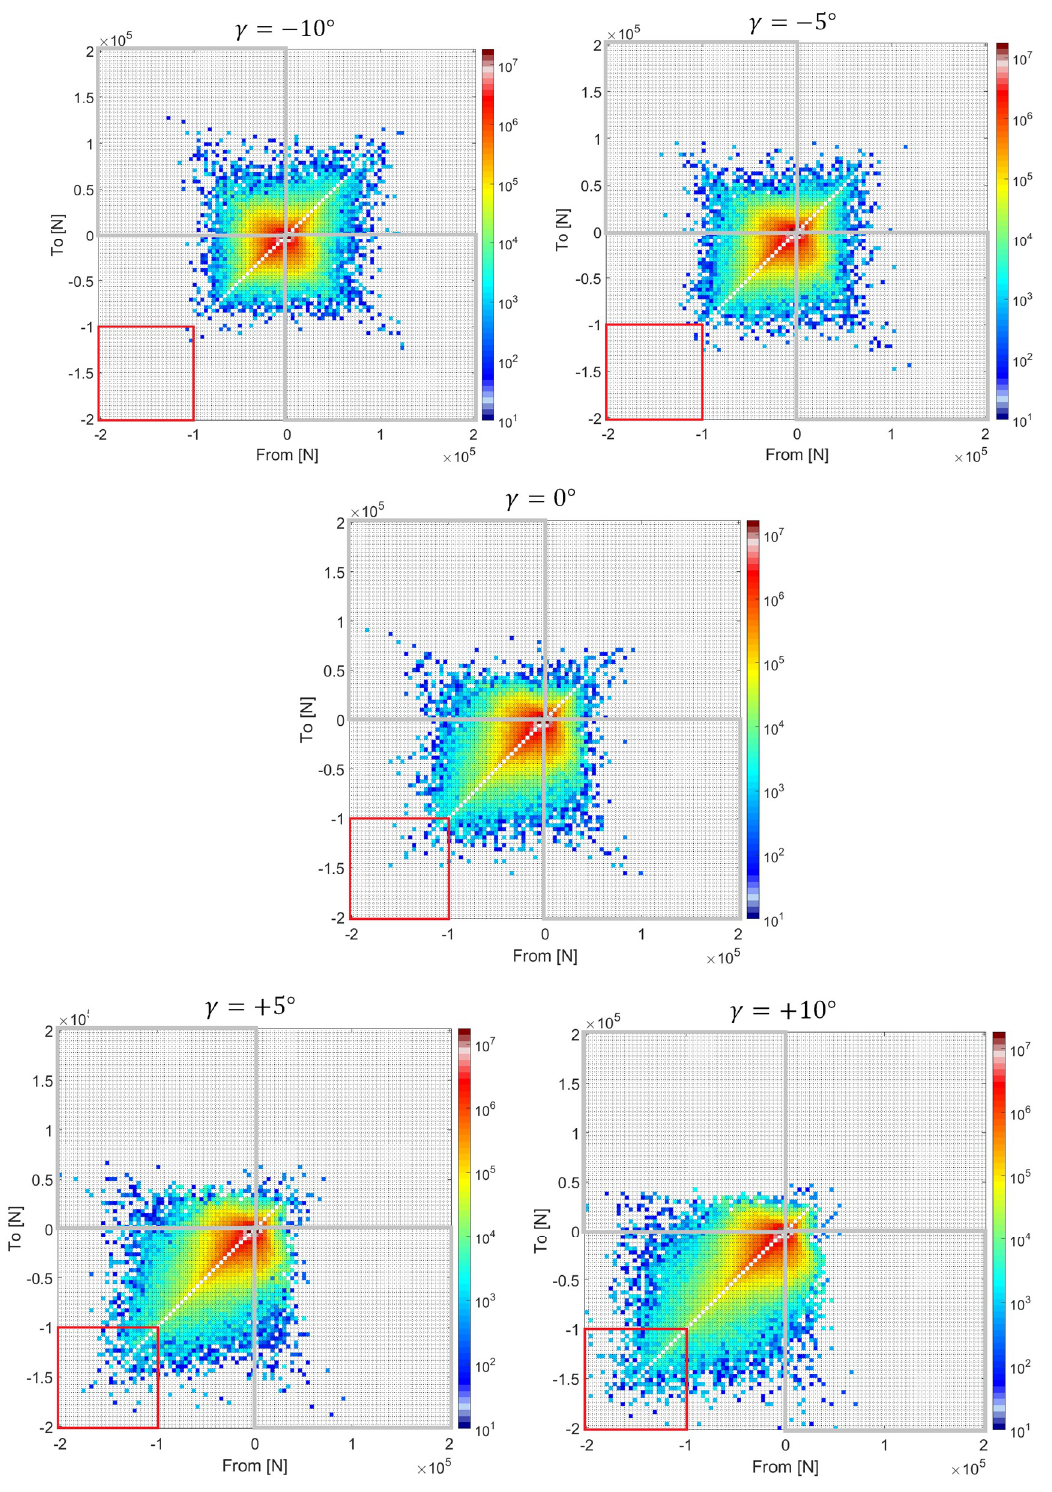
Figure 3. Rain flow count of the in-plane side force (y-axis) for various nacelle positions and a timespan of 20 years ( top left : −10°; top right : −5°; middle : 0°; bottom left : 5°; bottom right : 10°).